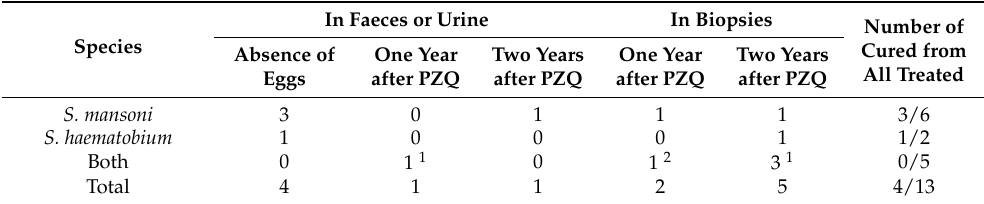
Table 1. Distribution of Schistosoma eggs found among 5510 foreign students and workers screened upon entry into Czech Republic between 1983 and 1989 (adapted from Giboda [24]). In Faeces or Urine In Species